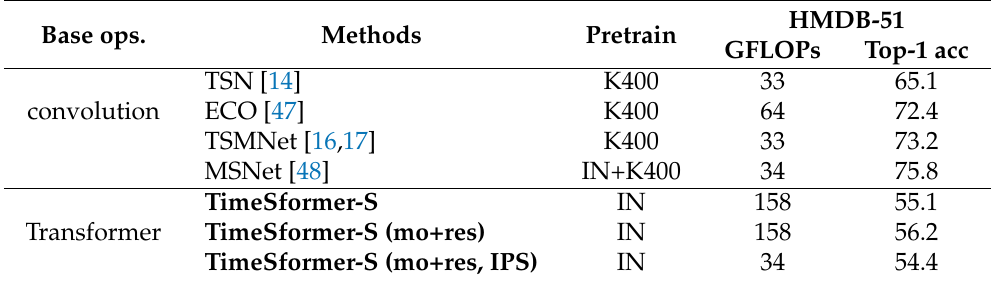
Table 4. Comparison with state-of-the-art methods on HMDB-51. ”IN” and ”K400” represent ImageNet [53,54] and Kinetics-400 [19], respectively. Our methods appear in boldface. ”mo+res” stands for taking P-frames as motions and residuals. All of our methods take 24 frames with the frame size of 144 × 144 and 6fps.